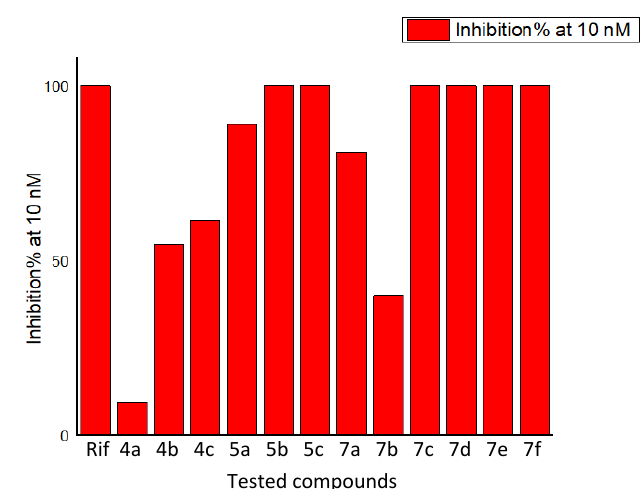
Figure 5. InhA enzyme inhibition percentage at 10 nM of the tested compounds. Table 1. The inhibitory effect (IC 50 ) of the tested compounds against InhA. Tested Compounds